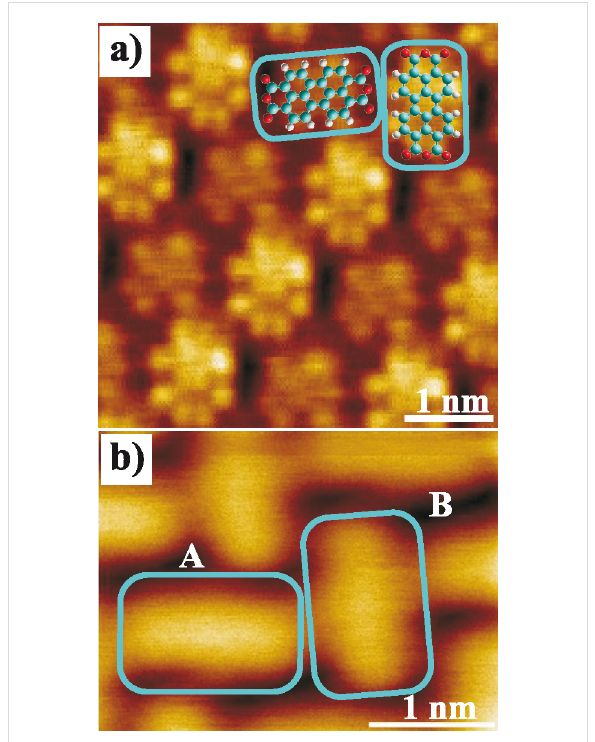
Figure 1: (a) STM topography scan ( V = 0.2 V, I = 0.3 nA) of PTCDA on Ag(111). The two molecule orientations (turquois rectangles) of the unit cell correspond to different adsorption geometries and are imaged with a different intensity. (b) NC-AFM topography scan ( Δ f = − 0.6 Hz) of the surface area where the 3D force spectroscopy measurement was performed. No difference between the two orientations is